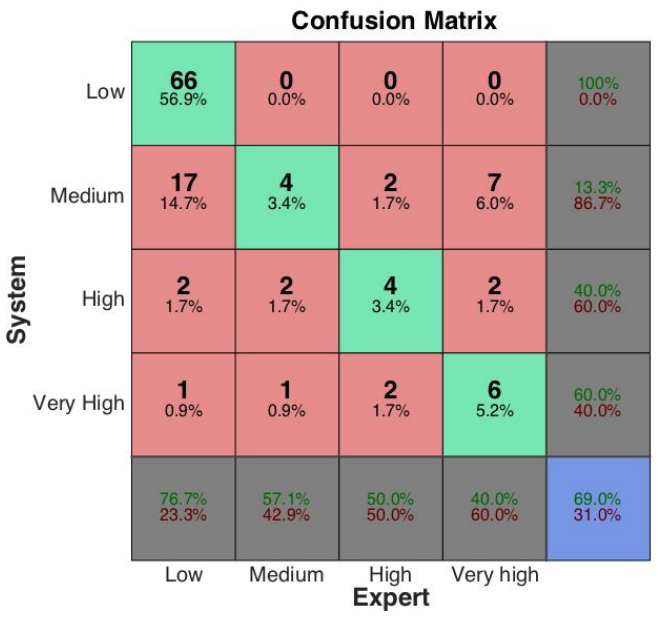
Figure 12. Confusion